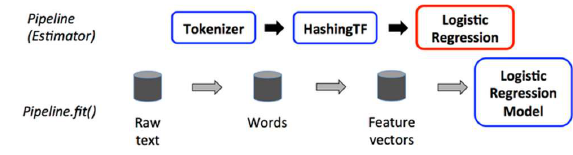
Figure 6. Initial DataFrame goes through pipeline